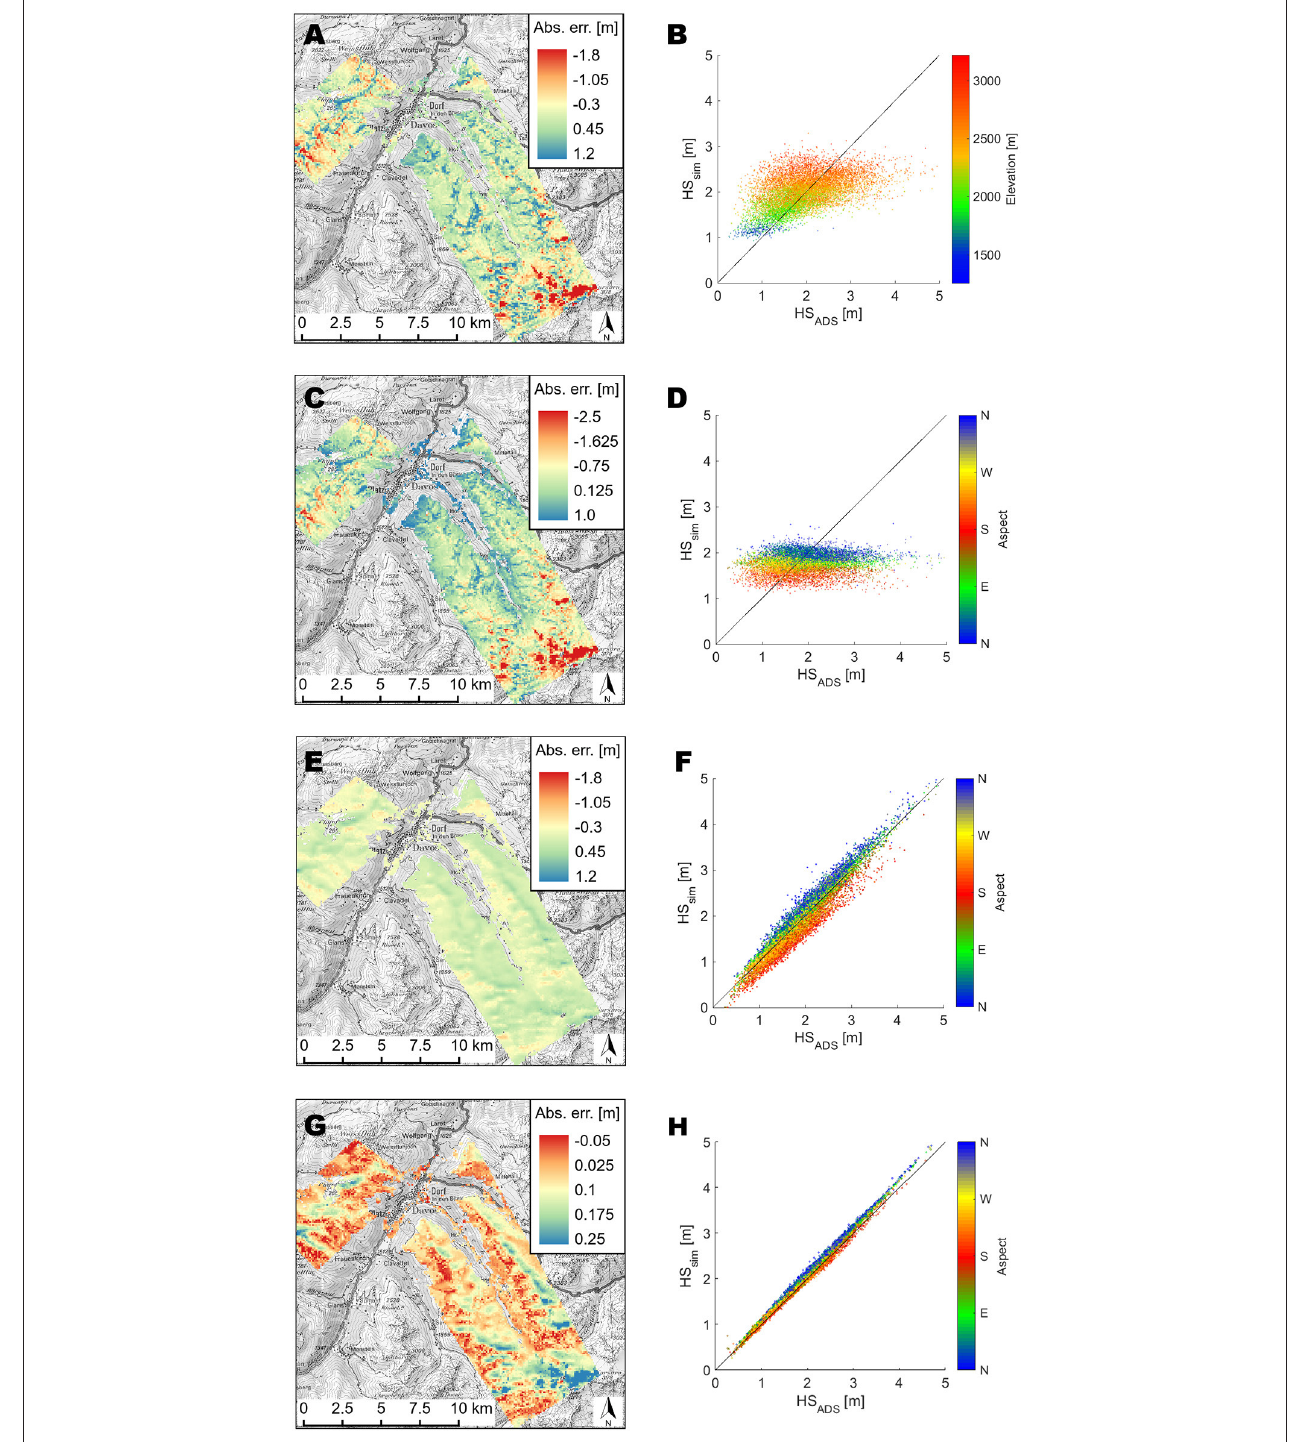
FIGURE 4 | (A,C,D,E,G) Maps of absolute errors in snow depth between simulation results and ADS dataset for 20 March 2012. (B,D,F,H) Scatter plots of simulated against ADS snow depth for 20 March 2012. The plots show [PSUM], [HS], [PAT], and [ALS2] simulation results from winter 2011/12. The range of the absolute errors show the 2–98 cumulative percentage of data for [PSUM], [HS], and [ALS2]. For [PAT] the data range is identical to the [PSUM] data range. Colors in scatter plots correspon to elevation in [PSUM] and aspect of the grid point for others. Maps reproduced by permission of swisstopo (JA100118).